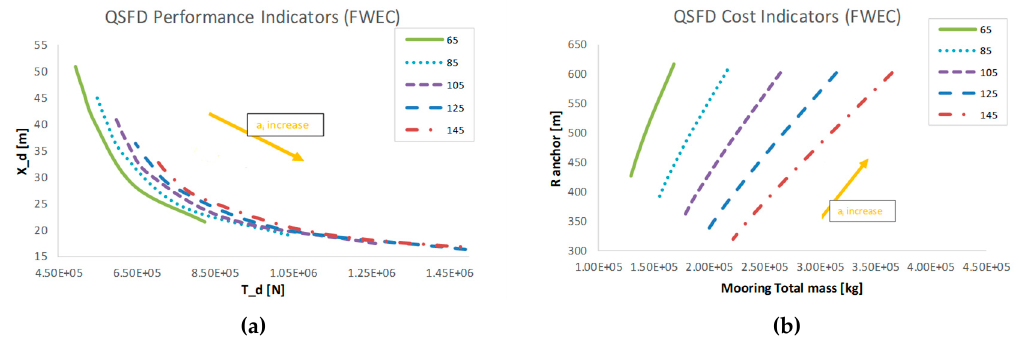
Figure 5. Baseline results of the QSFD model. Performance indicators of line design tension and design offset (a) and cost indicators of mooring total mass and anchor radius (b) .